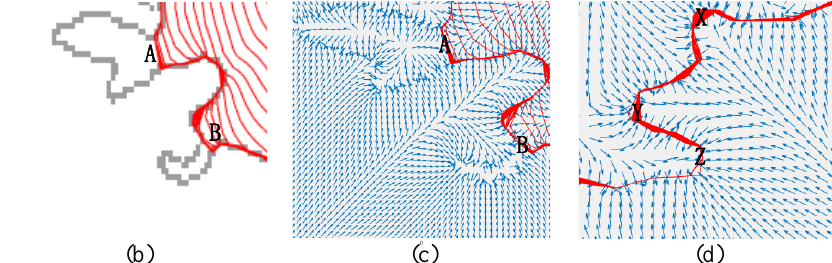
Figure 14. ( a ) Narrow concave boundary, ( b ) convergence results of narrow concave boundary, ( c ) external force field within the narrow boundary concavity, ( d ) external force field within an ordinary boundary concavity. The positions A and B are concave edges with a narrow entrance width and narrow width, respectively. X, Y, and Z are the positions where the external forces are perpendicular to the top of the U-shape.